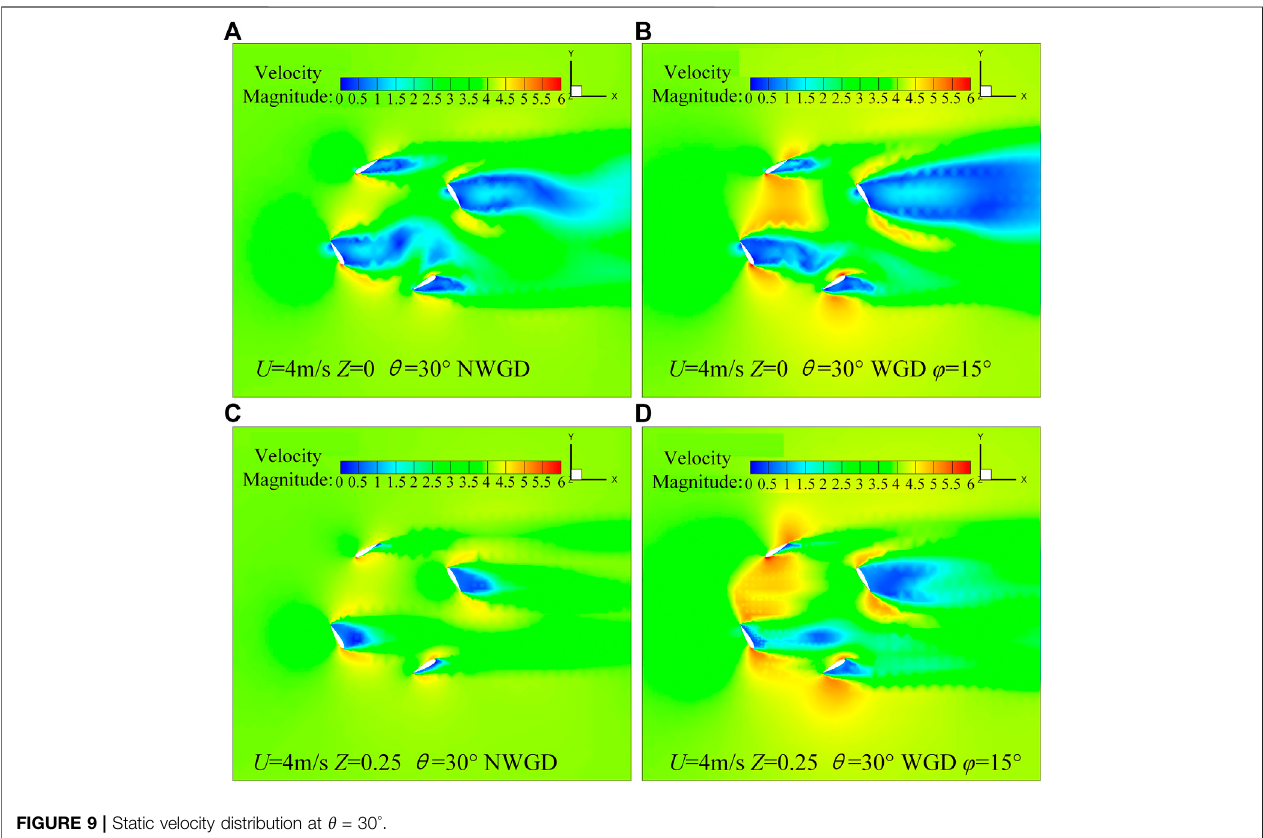
FIGURE 9 | Static velocity distribution at θ = 30 ° .